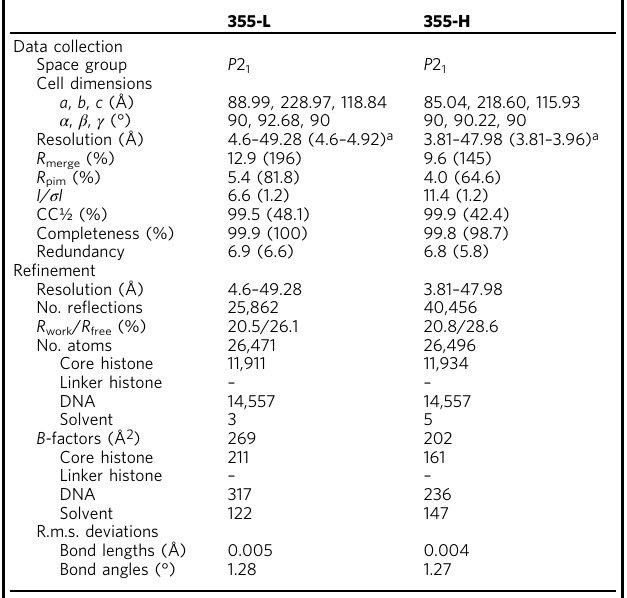
a Single crystal data sets; Values in parentheses are for the highest resolution